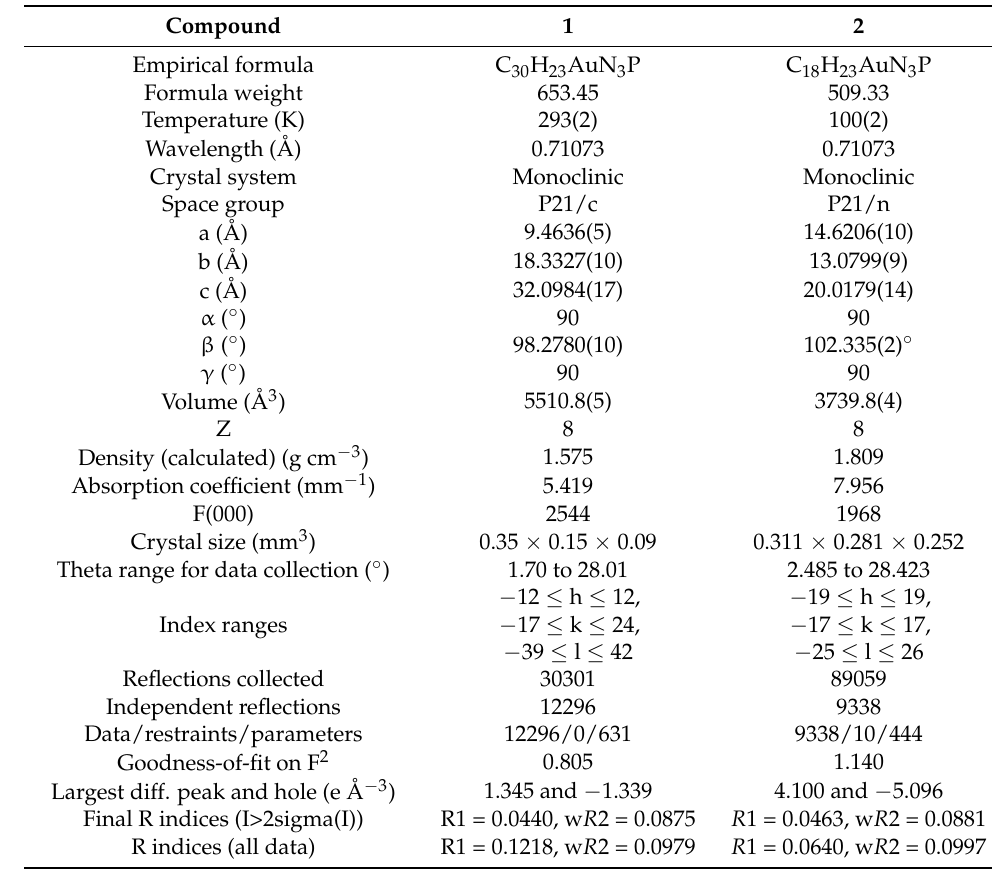
Table 4. Crystal data and structure refinement for 1 and 2